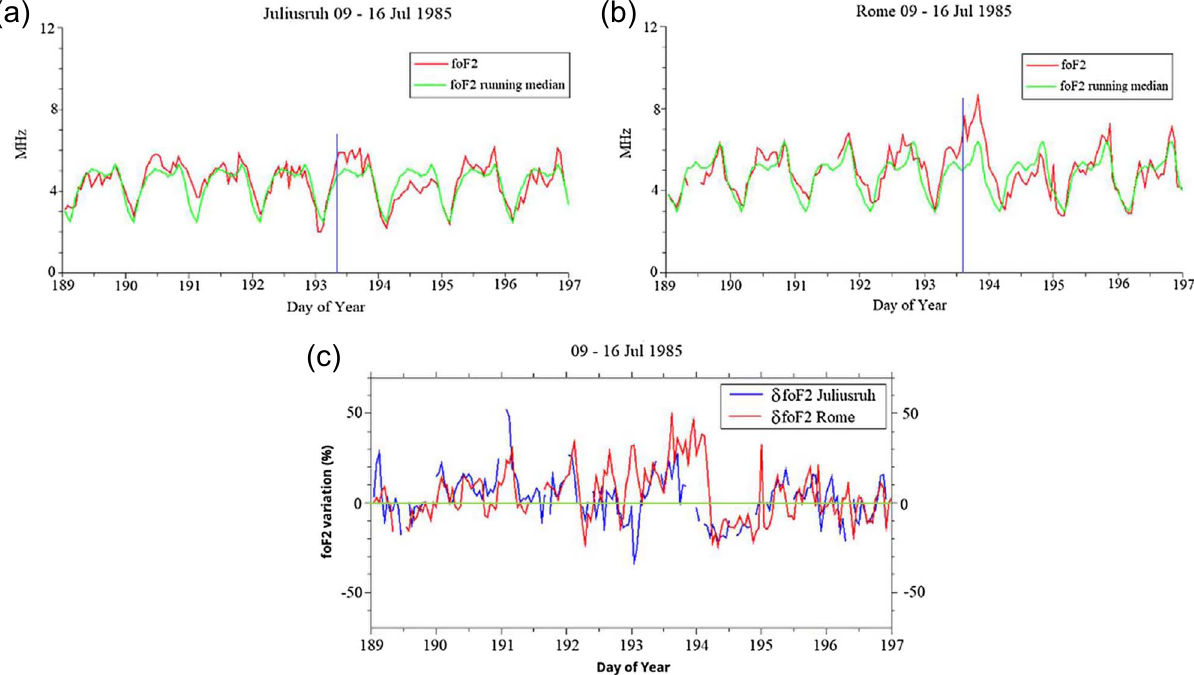
Fig. 5. (a) Hourly values of foF2 as recorded at Juliusruh ionospheric station from 09 to 16 July 1985 (red line) together the foF2 running median evolution in the same period (green line). The latter is considered as a background value of the ionospheric parameter. (b) Hourly values of foF2 as recorded at the Ionospheric Observatory of Rome from 09 to 16 July 1985 (red line) together the foF2 running median evolution in the same period (green line). The blue vertical lines in the plots represent the onset of the strong positive phase of the ionospheric storm recorded in the two observatories. In panel (c) is reported the variation in percentage of the foF2 for the two ionospheric stations, for the considered